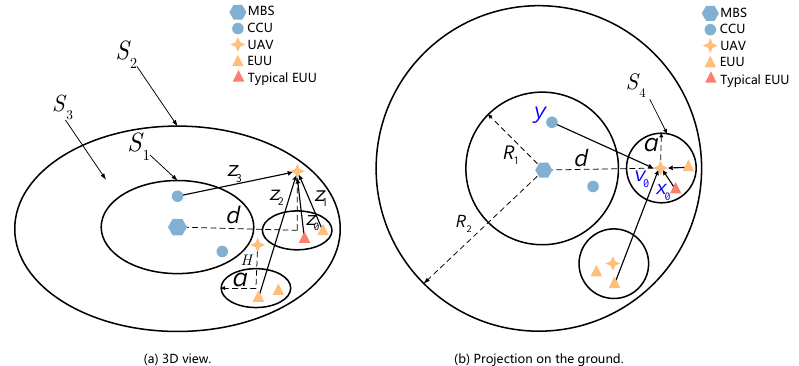
Figure 1. The network model of UAV-assisted network with clustered edge